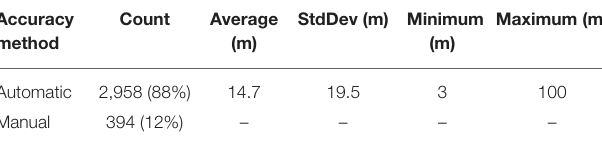
TABLE 4 | Location accuracy estimates are derived by pinging the phone’s GPS location service up to 10 times or until the accuracy error is < 50